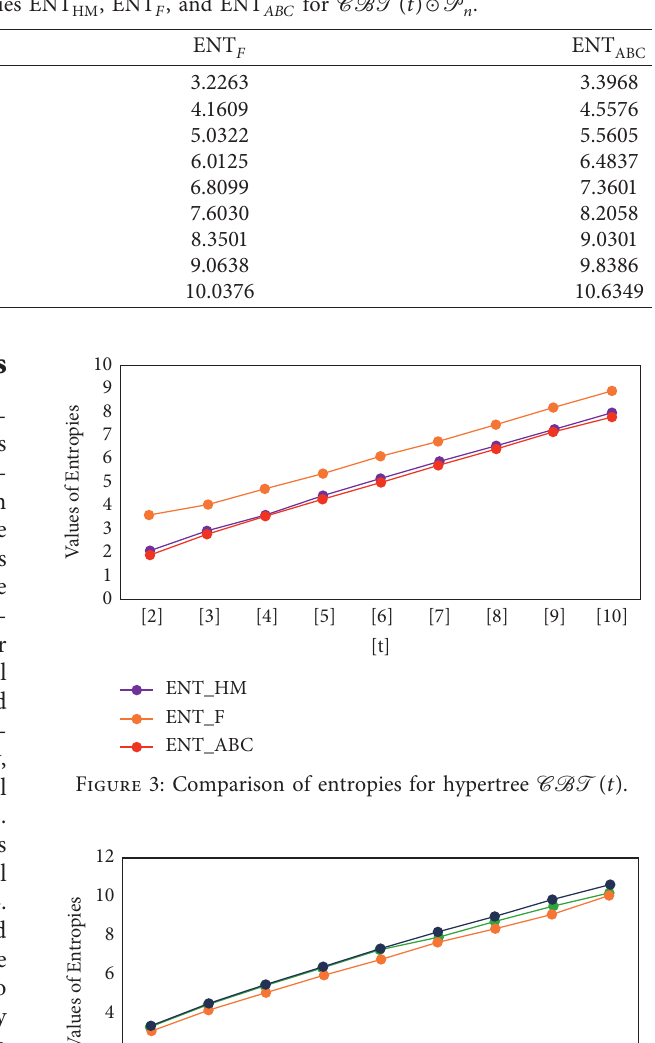
Table 7: Comparison of degree-based entropies ENT [ t ] ENT HM